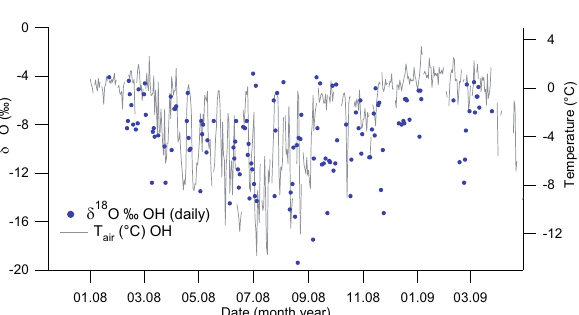
Fig. 6. Isotopic composition of precipitation samples (blue dots) collected at O’Higgins station in a daily schedule during Febru- ary 2008 and March 2009. The mean daily temperatures (light grey line) for O’Higgins are displayed as well. A high variability of air temperature and isotope data is observed, especially during the win- ter season.